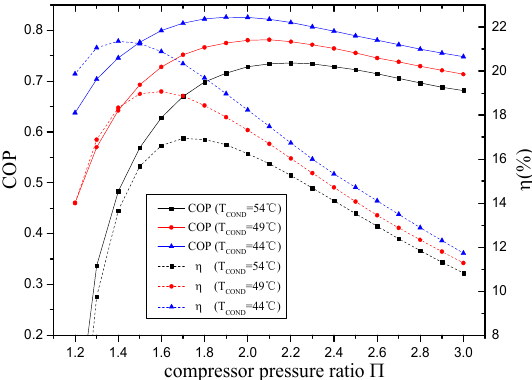
Figure 20. COP and η of configuration 1 versus π at different T COND .